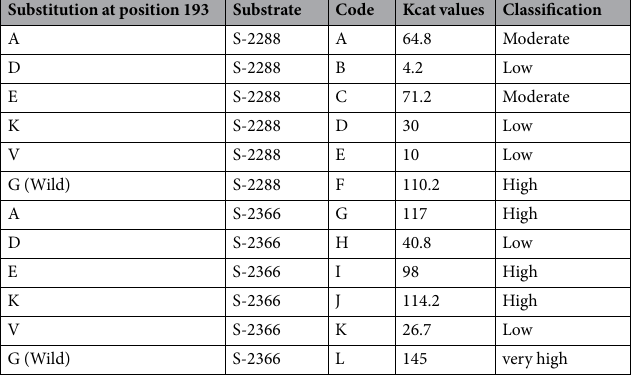
Table 1. Table shows the experimental activity values of enzymes with different substitutions at position 193 against two different substrates. The enzymes are classified based on the K cat values as explained in the